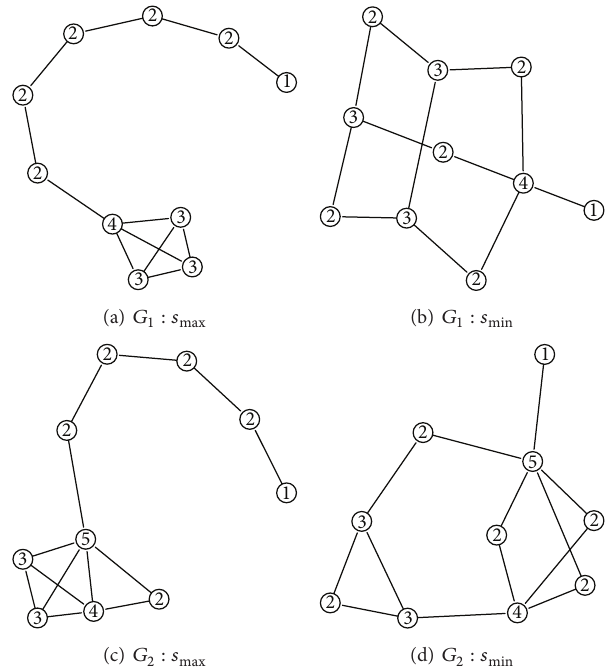
Figure 2: Graphs that have maximal value 𝑠 ((a) and (b)) and minimalvalues((c)and(d))forthegraphs 𝐺 1 and 𝐺 2 corresponding to the ones in Figure 1. Degrees are inside the